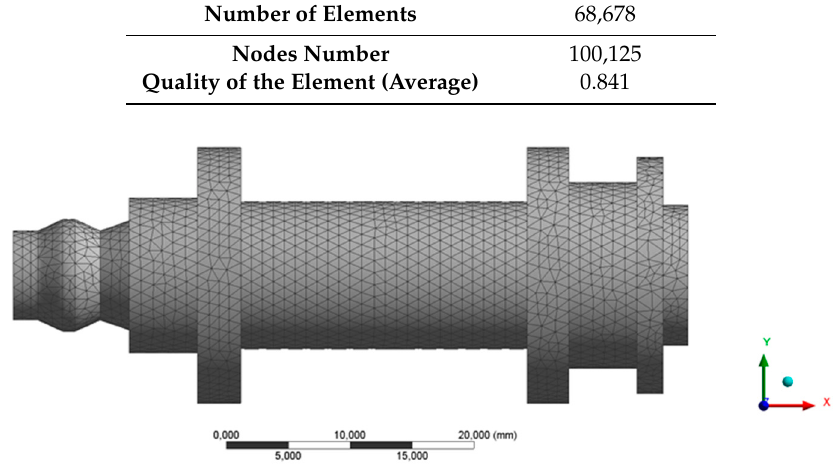
Figure 20. Mesh generated for the numerical simulation. Table 11. Statistics of the mesh generated for the mechanical modeling.